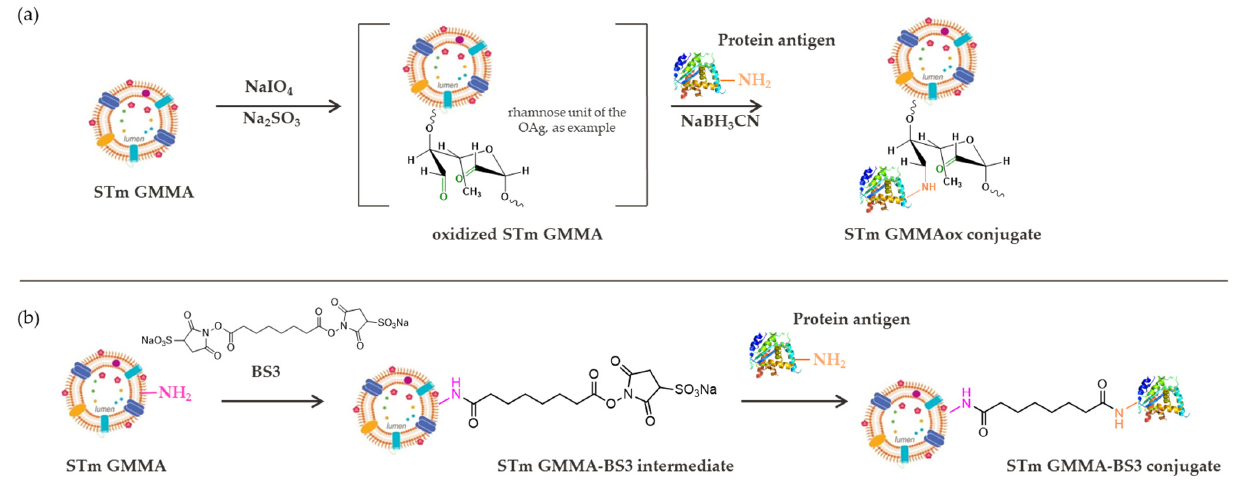
Figure 1. Two novel simple conjugation chemistries developed for decoration of GMMA with heterologous antigens, using STm GMMA as models: ( a ) oxidation of LPS/LOS molecules on GMMA followed by reductive amination with the antigen of interest, ( b ) functionalization of proteins on GMMA with the BS3 linker followed by immediate reaction with the antigen of interest.